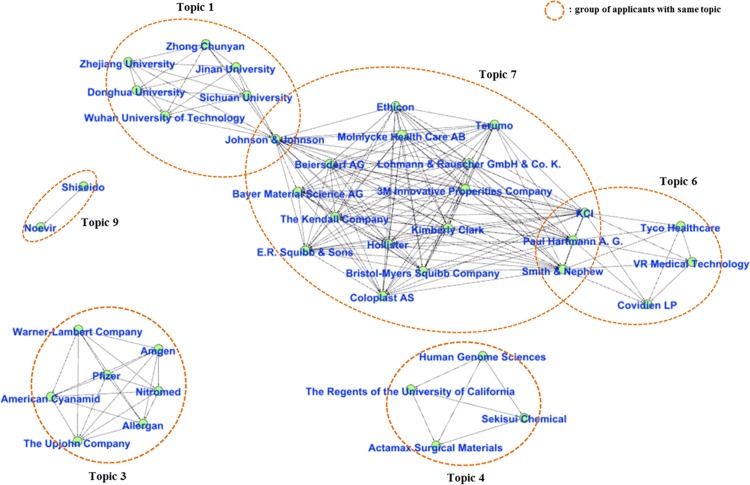
Co-topic network.